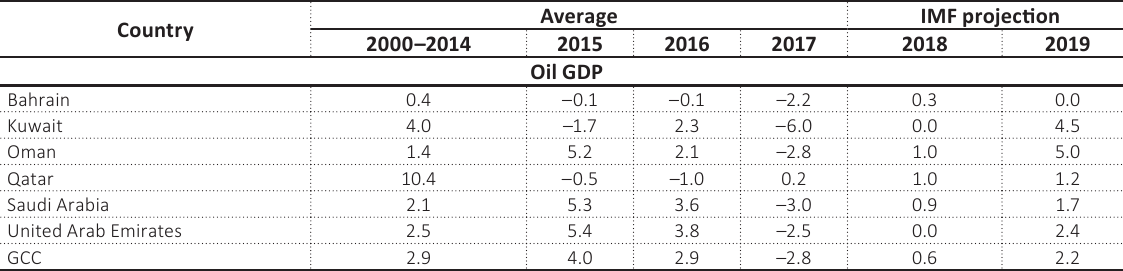
Table 3 (cont.). Oil exports: growth in crude and non-crude GDP (%)